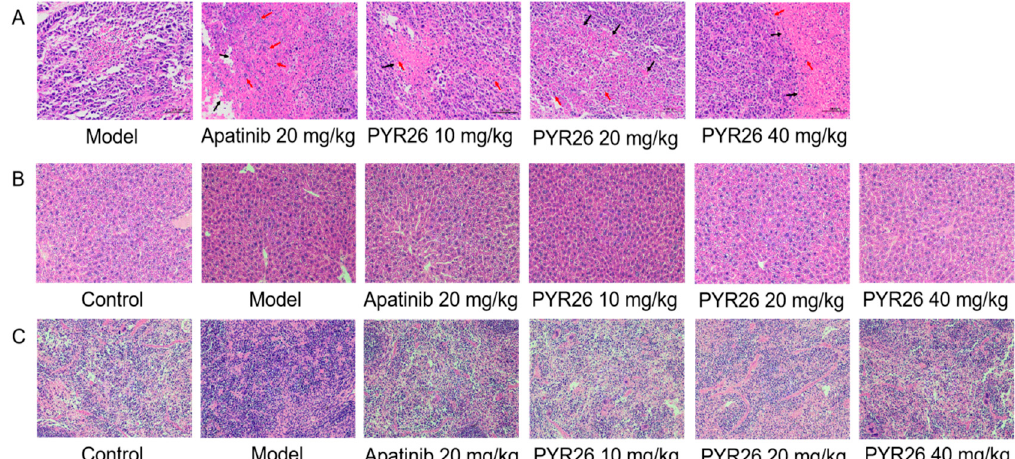
Figure 10. ( A ) In the positive control group (apatinib), the cytoplasmic ratio was high and the nuclei were heteromorphic. About 2/5 of the tumor cells were necrotic in patches, with necrotic nucleolysis and increased eosinophilic cytoplasm (black arrow) and a small amount of granulocyte infiltration in the necrotic lesions (red arrow). The low-concentration PYR26 group showed high cytoplasmic ratio, abnormal nuclei, small focal necrosis regions, nucleolysis, enhanced eosinophilic cytoplasm (black arrow), and small amount of granulocyte infiltration (red arrow). In the medium-concentration PYR26 group, the tumor had high cytoplasmic ratio, abnormal nuclei, focal necrosis of multiple tumor cells, deep staining, dissolution of nucleus pyknosis, enhanced eosinophilic cytoplasm (black arrow), accompanied by a small amount of granulocyte infiltration (red arrow). The high-concentration PYR26 group showed high cytoplasmic ratio and heteromorphic nuclei, with patellar necrosis of nearly half of the tumor cells, lysis of necrotic nuclei, enhanced eosinophilic cytoplasm (black arrow) and a small amount of granulocyte infiltration in the necrotic lesions (red arrow). ( B ) Compared with the control group, model group liver tissue increased cell size and shape, with abnormal, obviously increased nuclear/cytoplasmic ratios, deep staining, disorderly spatial arrangement, with dot necrosis of liver cells and inflammatory cell infiltration. The color of the staining of Apatinib and PYR26 groups is shallow. The hepatic lobule of medium-concentration and high-concentration PYR26 groups are complete, the color becomes light, similar to the blank group. ( C ) In the blank group, the white pulp and red pulp areas of spleen sections were obvious, with obvious demarcation and clear marginal areas, while in the model group, the spleen sections of nude mice had loose texture and no obvious marginal areas. In contrast, the apatinib group and PYR26 group both had obvious marginal areas, and the ratio of red pulp to white pulp was close to that of the blank group ( ×